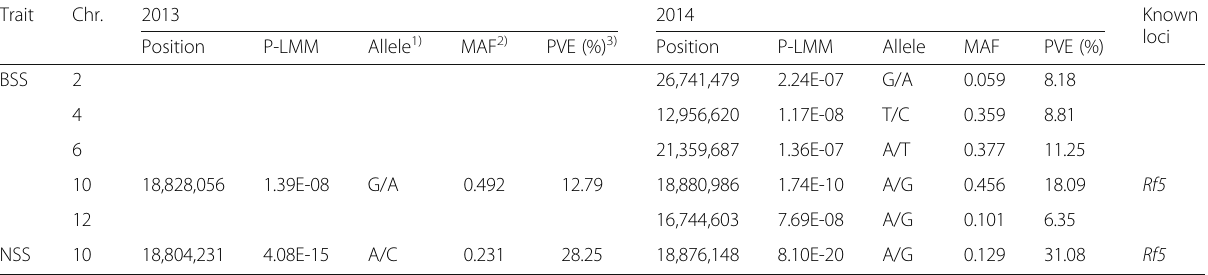
Table 2 Genome-wide significant associations for BSS and NSS of the F 1 population with the background of CMS-HL in year 2013 and 2014 using the linear mixed model Trait Chr.